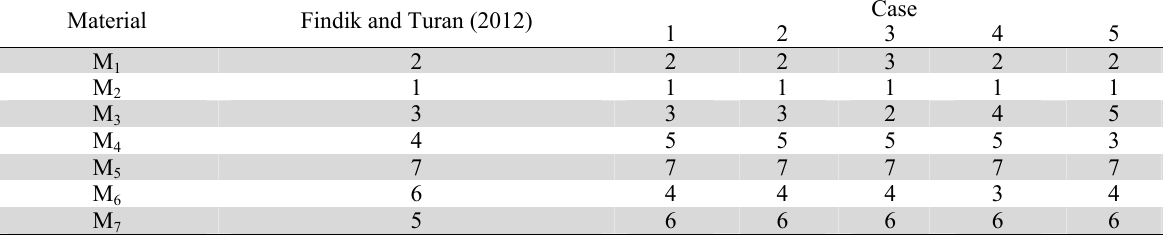
Rankings of light load wagon wall materials using PROMETHEE method Material Findik and Turan (2012)